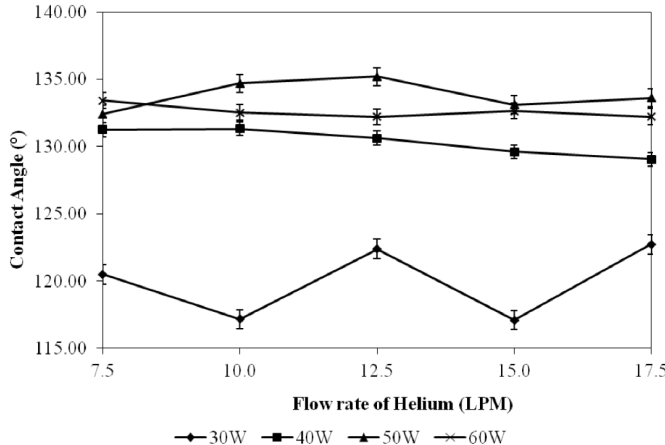
Figure 3. Contact angle of rayon flock synthetic leather after TMS plasma treatment (treatment parameters: amount of TMS = 0.2 mL; jet distance = 10 mm; treatment time = 30 s).